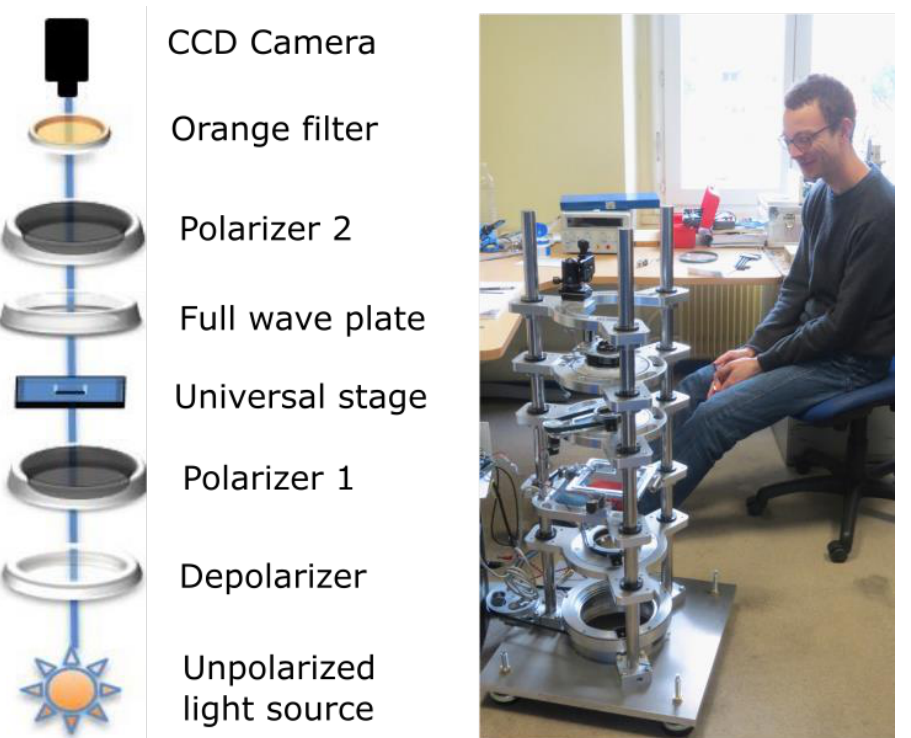
Figure 2. The automated optical bench — the heart slice embedded in MMA is positioned on a universal stage for the acquisition of the forty-nine images necessary to extract the orientation information.